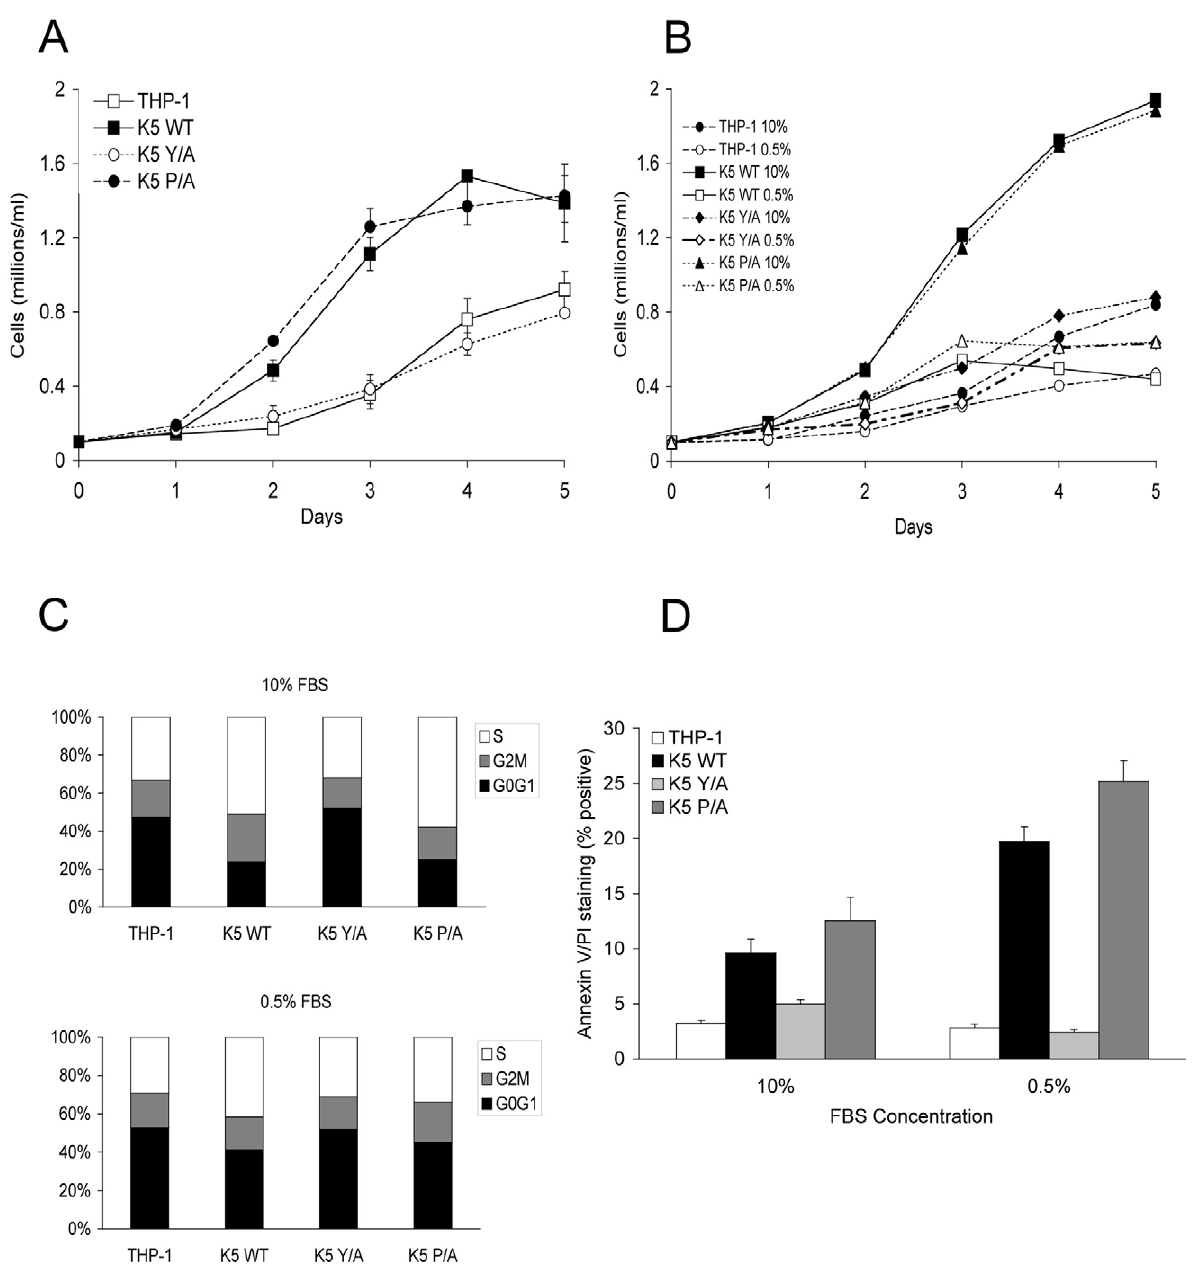
Figure 1. THP-1 cells stably expressing wild-type K5 have increased growth rate, which is serum dependent. THP-1 cell lines were seeded at 0.1 x 10 6 cells/ml in RPMI media supplemented with ( A ) 10% FBS or ( B ) 5% and 0.5% FBS, as indicated, in triplicates. Viable cell numbers and averages were determined for each day. ( C ) Equal numbers of indicated THP-1 cell line in medium with either 10% FBS (top panel) or 0.5% FBS (bottom panel), were examined for cell cycle profile, as described in the Methods, at three days post-seeding. Results are representative of three independent experiments. ( D ) Each of the indicated THP-1 cells was seeded in triplicate at 0.1 x 10 6 cells/ml in medium containing the indicated serum concentration. Five days post-seeding cells were examined for apoptosis. The percentage of cells doubly stained for Annexin V and propidium iodide are indicated.